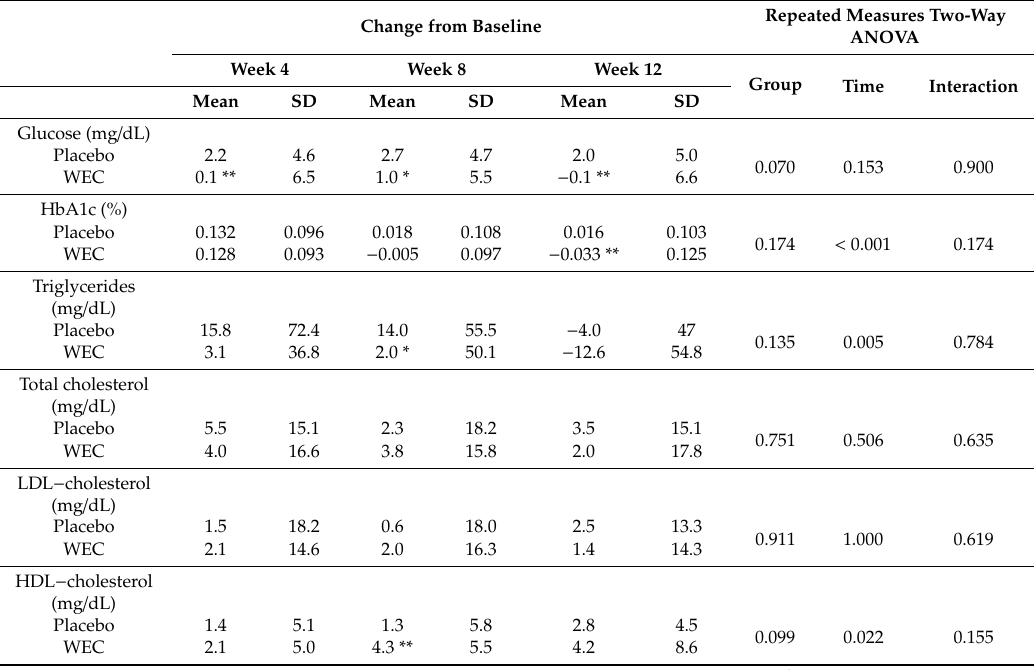
Repeated Measures Two-Way ANOVA Group Time Interaction